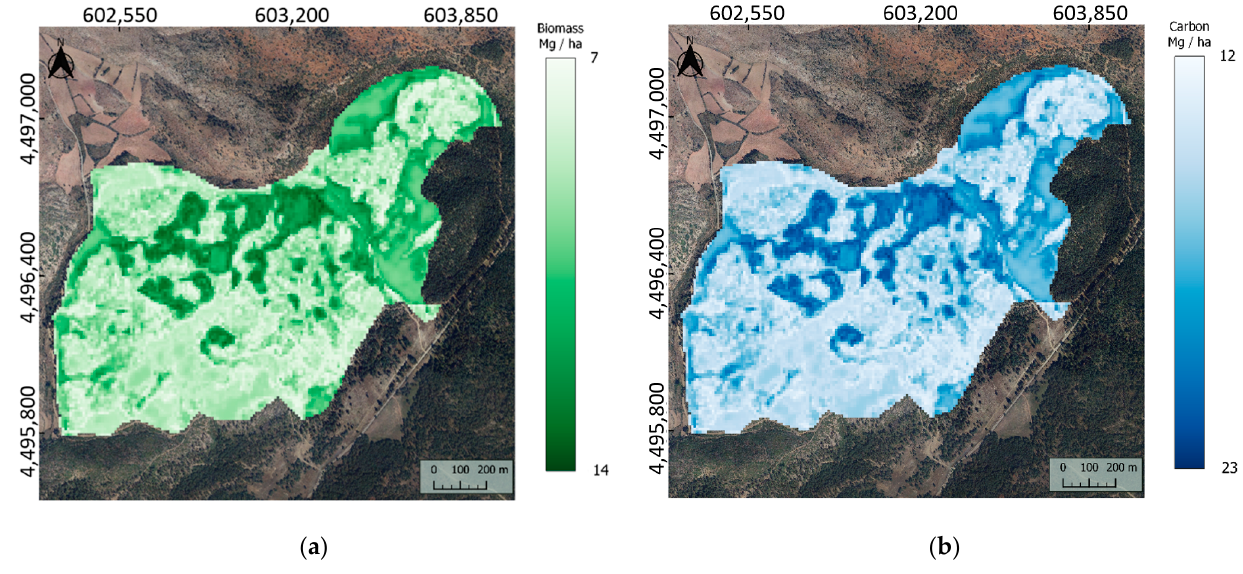
Figure 6. Actual shrub biomass and carbon stock 8 years after a fire burning a forest of Pinus sylvestris L. in Chequilla, Spain: ( a ) biomass of a regenerated shrub structure of Quercus pyrenaica Willd. (Mg·ha − 1 ), 2020; ( b ) carbon stock of a regenerated shrub structure of Quercus pyrenaica Willd. (Mg C·ha − 1 ), 2020.